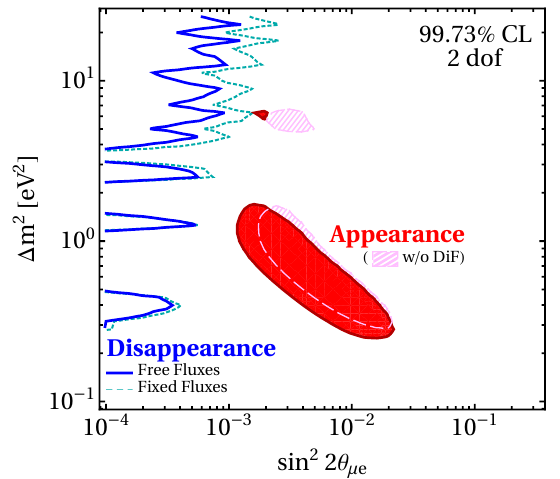
Figure 7 . Appearance versus disappearance data in the plane spanned by the e(cid:11)ective mixing angle sin 2 2 (cid:18) (cid:22)e (cid:17) 4 j U e 4 U (cid:22) 4 j 2 and the mass squared di(cid:11)erence (cid:1) m 2 from the disappearance data sets using free reactor (cid:13)uxes (solid) or (cid:12)xed reactor (cid:13)uxes (dashed), while the shaded contours are based on the appearance data sets using LSND DaR+DiF (red) and LSND DaR (pink hatched). All contours are at 99.73% CL for 2